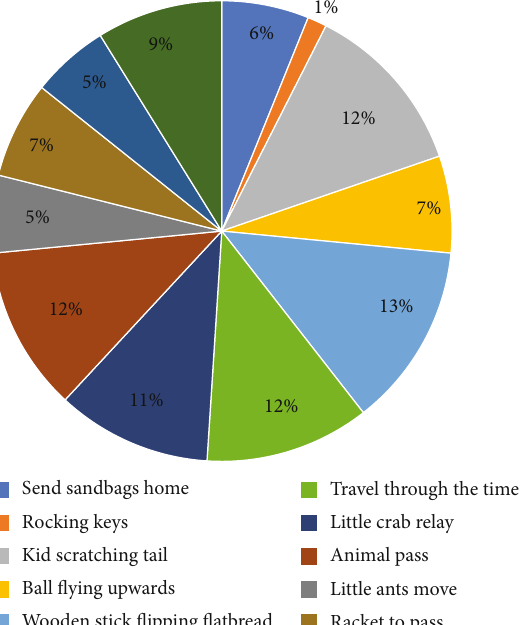
Figure 3: Course